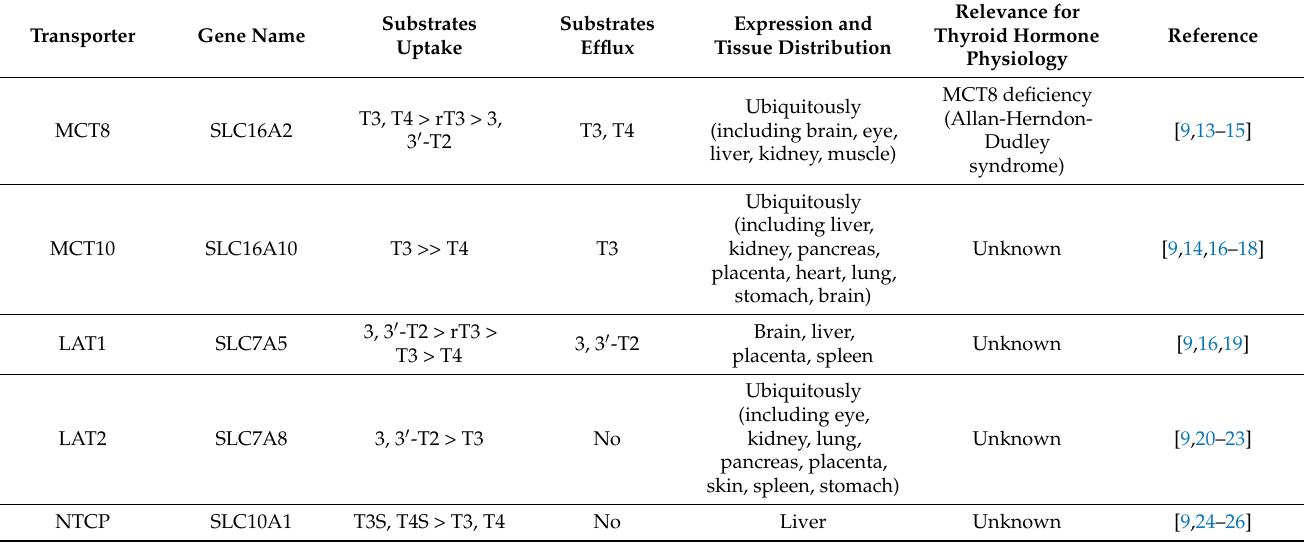
Table 1. Overview of the main characteristics of human thyroid hormone